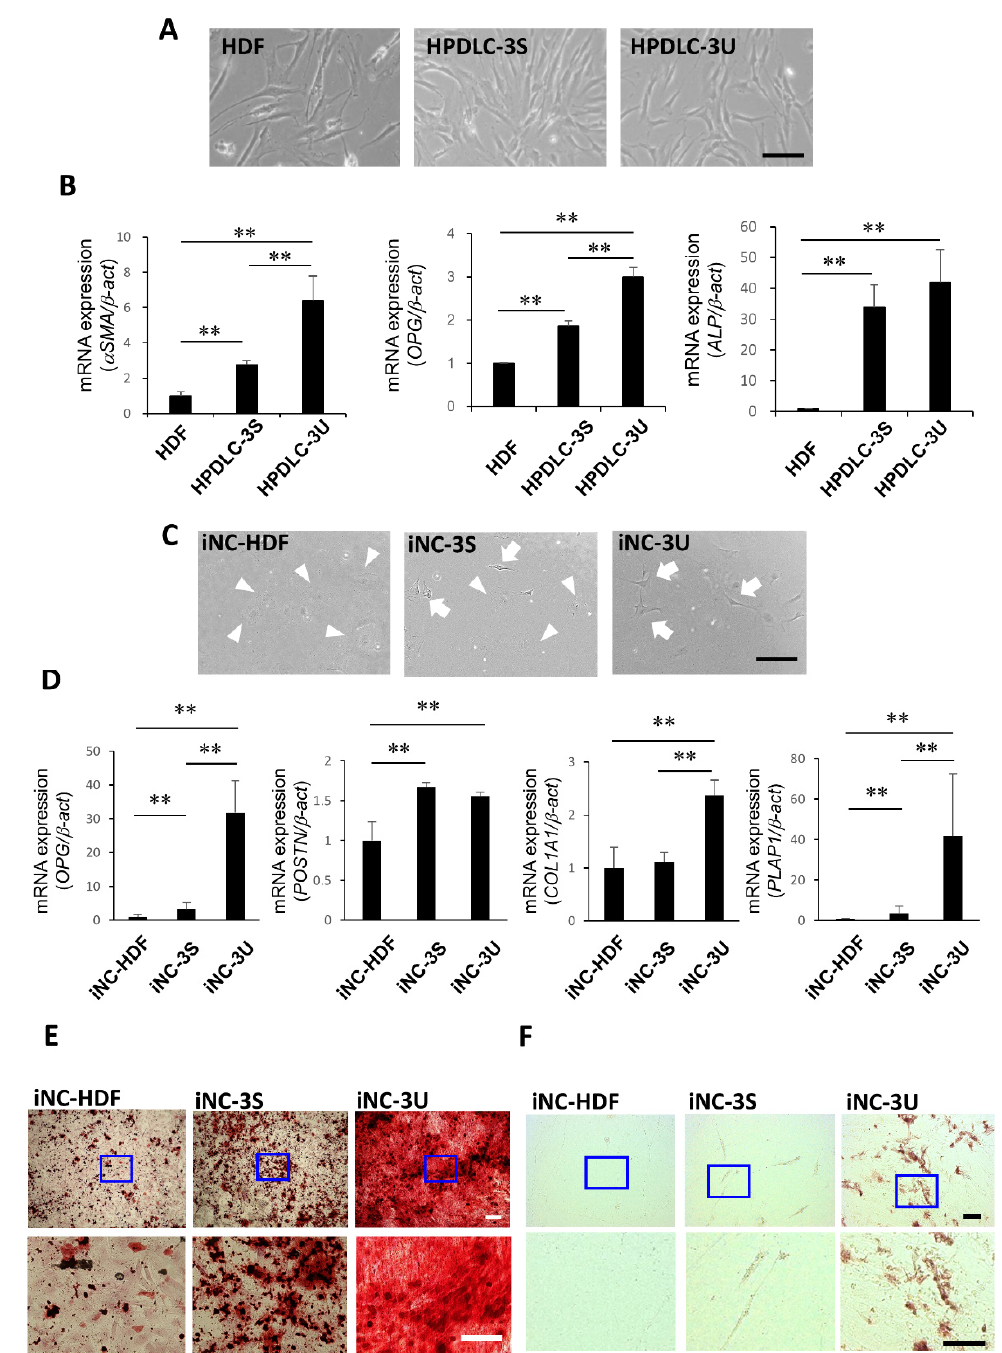
Figure 1. Comparison of PDLSC-like characteristics between iNC-HDF, iNC-3S, and iNC-3U ( A ) Representative phase-contrast microscopic images of HDF, HPDLC-3S, and HPDLC-3U. Bar = 100 µ m. ( B ) Quantitative real time RT-PCR analysis of PDL-related genes α -SMA , OPG , and ALP , in HDF, HPDLC-3S, and HPDLC-3U. β -act was used as an internal standard. Data portrayed are the mean ± standard deviation ( n = 4). ** p < 0.01. ( C ) Representative phase-contrast microscopic images of iNC-HDF, iNC-3S, and iNC-3U. White arrowheads indicate cells with rounded shapes and white arrows indicate cells with spindle shapes. Bar = 100 µ m. ( D ) Quantitative real-time RT-PCR analysis of iPDLSC-associated genes OPG , POSTN , COL1A1 , and PLAP1 in iNC-HDF, iNC-3S, and iNC-3U. β -act was used as an internal standard. Data portrayed are the mean ± standard deviation ( n = 4). ** p < 0.01. ( E ) Representative Arizarn Red S-staining images of iNC-HDF, iNC-3S, and iNC-3U after 3 weeks of culture in ODM. Upper panels portrayed the lower magnification images of iNC-HDF,